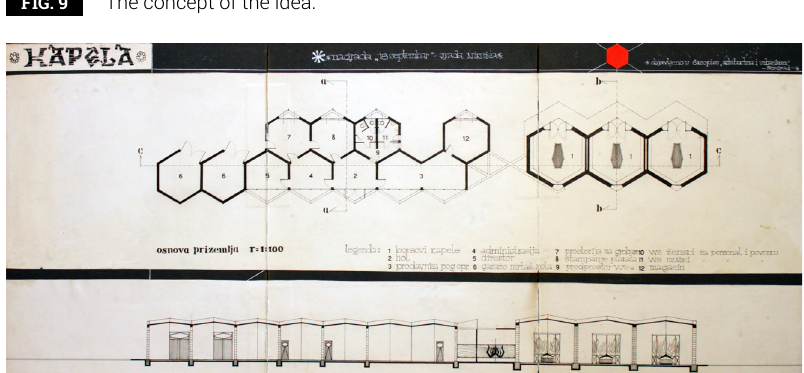
The concept of the idea.